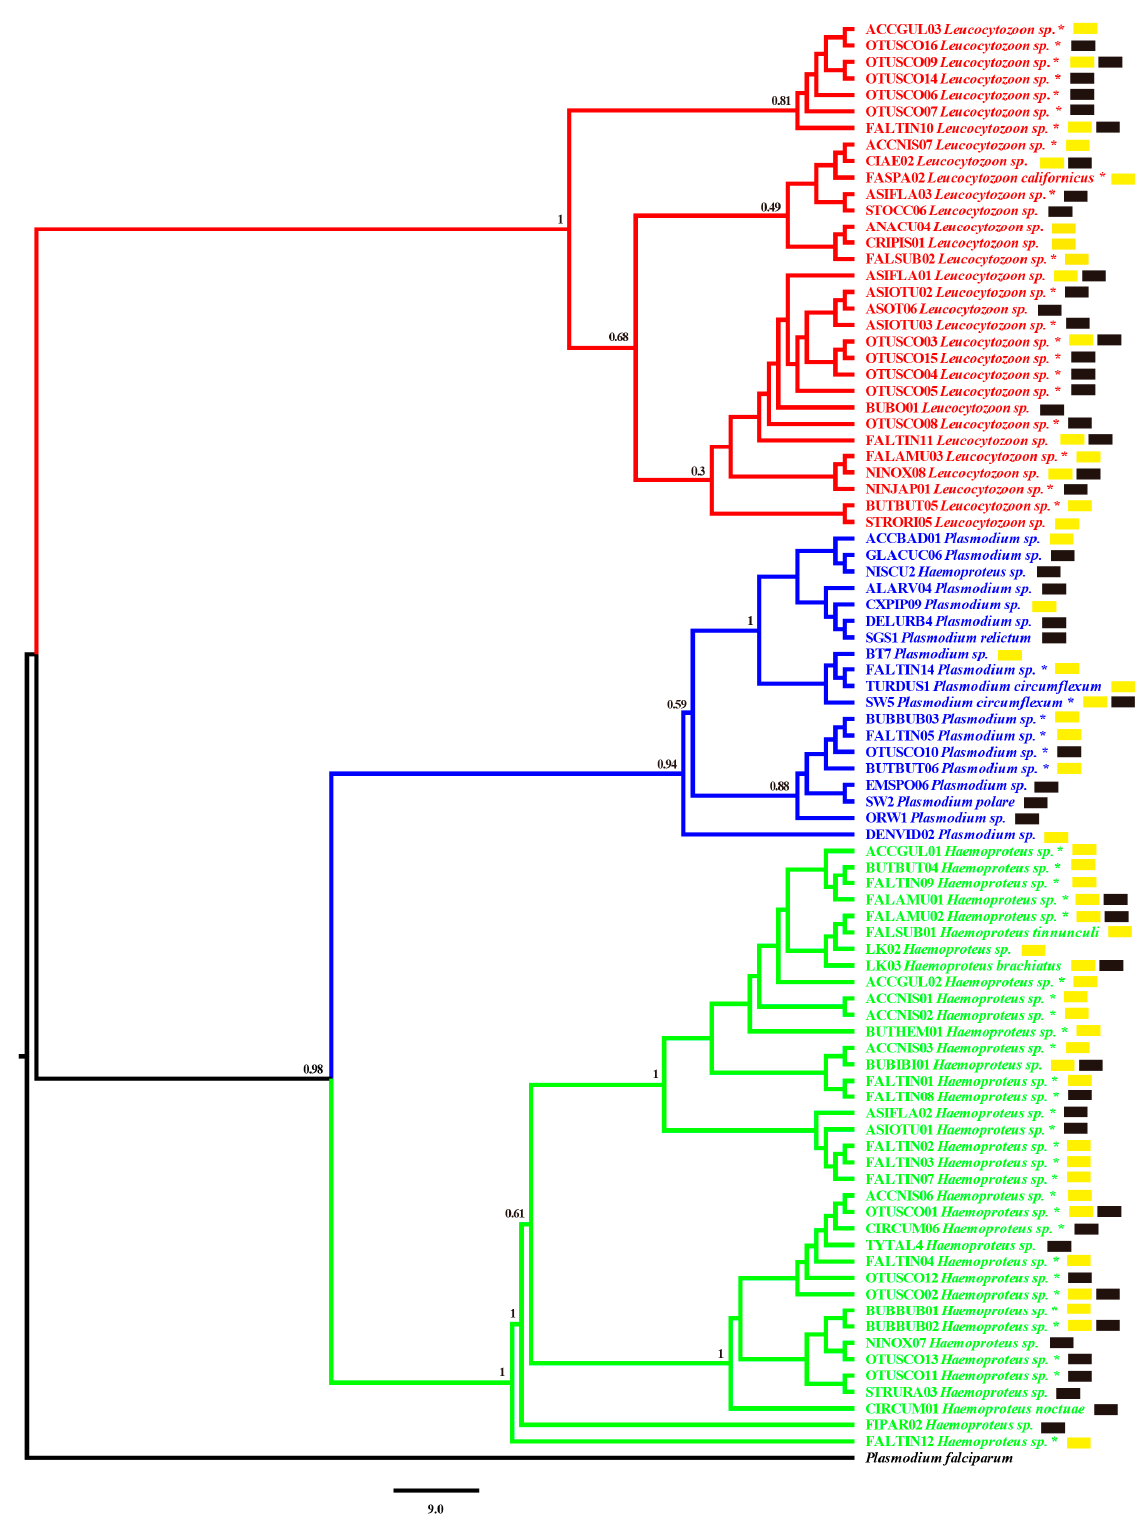
Figure 1. Phylogenetic relationship of 87 mitochondrial cytochrome b (cyt b ) parasite lineages of raptors from the genera Leucocytozoon , Haemoproteus and Plasmodium . Posterior probability values are shown above nodes. The scale bar represents 0.03 substitutions per nucleotide position. The Leucocytozoon , Haemoproteus and Plasmodium lineages are shown in red, blue and green, respectively. The names of parasite species are given if they were identified at the lineage level. The asterisks indicate newly described lineages. The coloured boxes represent the hosts in which certain lineages were detected, i.e., detected in diurnal ( yellow ) or nocturnal ( black ) raptors.